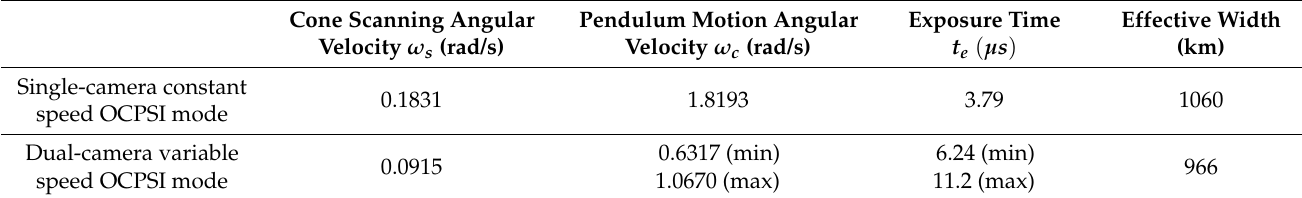
Table 1. Comparison table of related parameters of the two imaging modes.